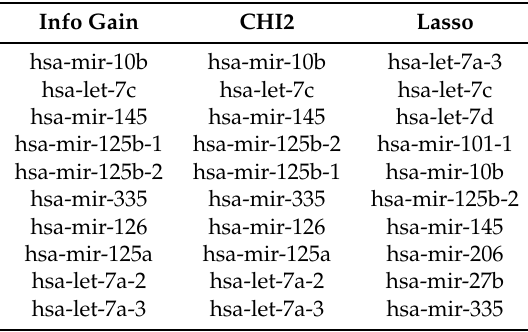
Table 3. Top Ranked Features Under Different Feature Selection